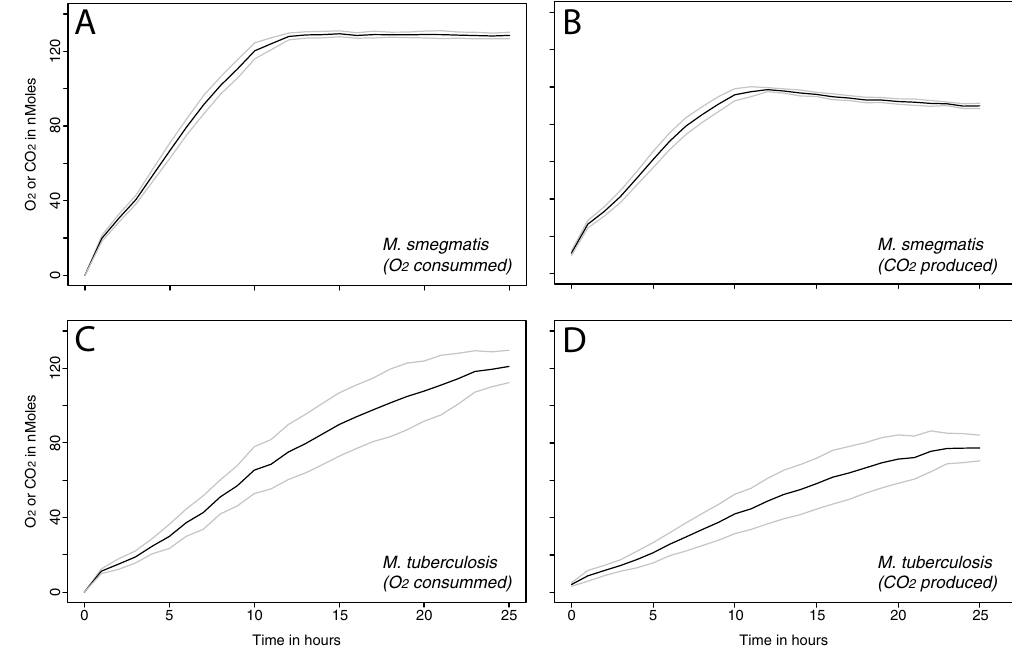
Figure 3. Oxygen consumption and carbon dioxide production by biofilms of M. smegmatis and M. tuberculosis . ( A , B ) Oxygen consumption and carbon dioxide production by biofilms of M. smegmatis . ( C , D ) Oxygen consumption and carbon dioxide production by biofilms of M. tuberculosis . Black lines represent the average of 4 replicates and grey lines represent the upper and lower values of standard deviations.